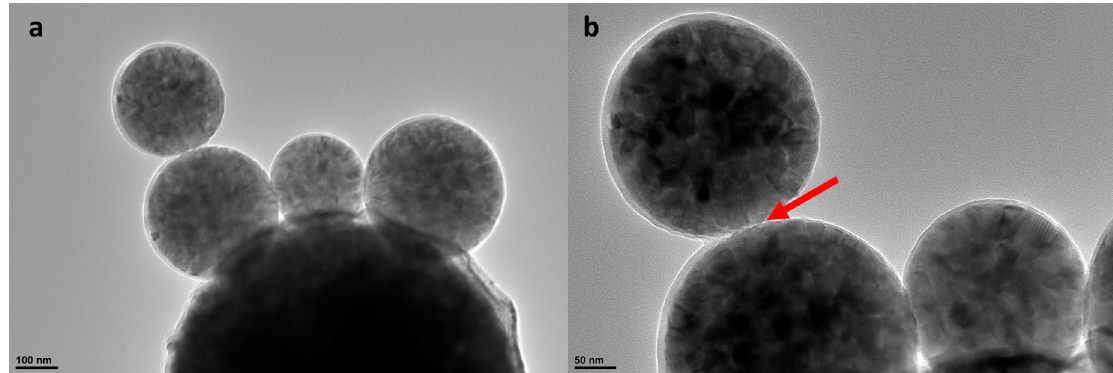
Figure 2. TEM analyze of the TiO 2 : ( a ) spherical nanoparticles; and ( b ) detail showing that the individual nanoparticles are building the soft agglomerates (see arrow).